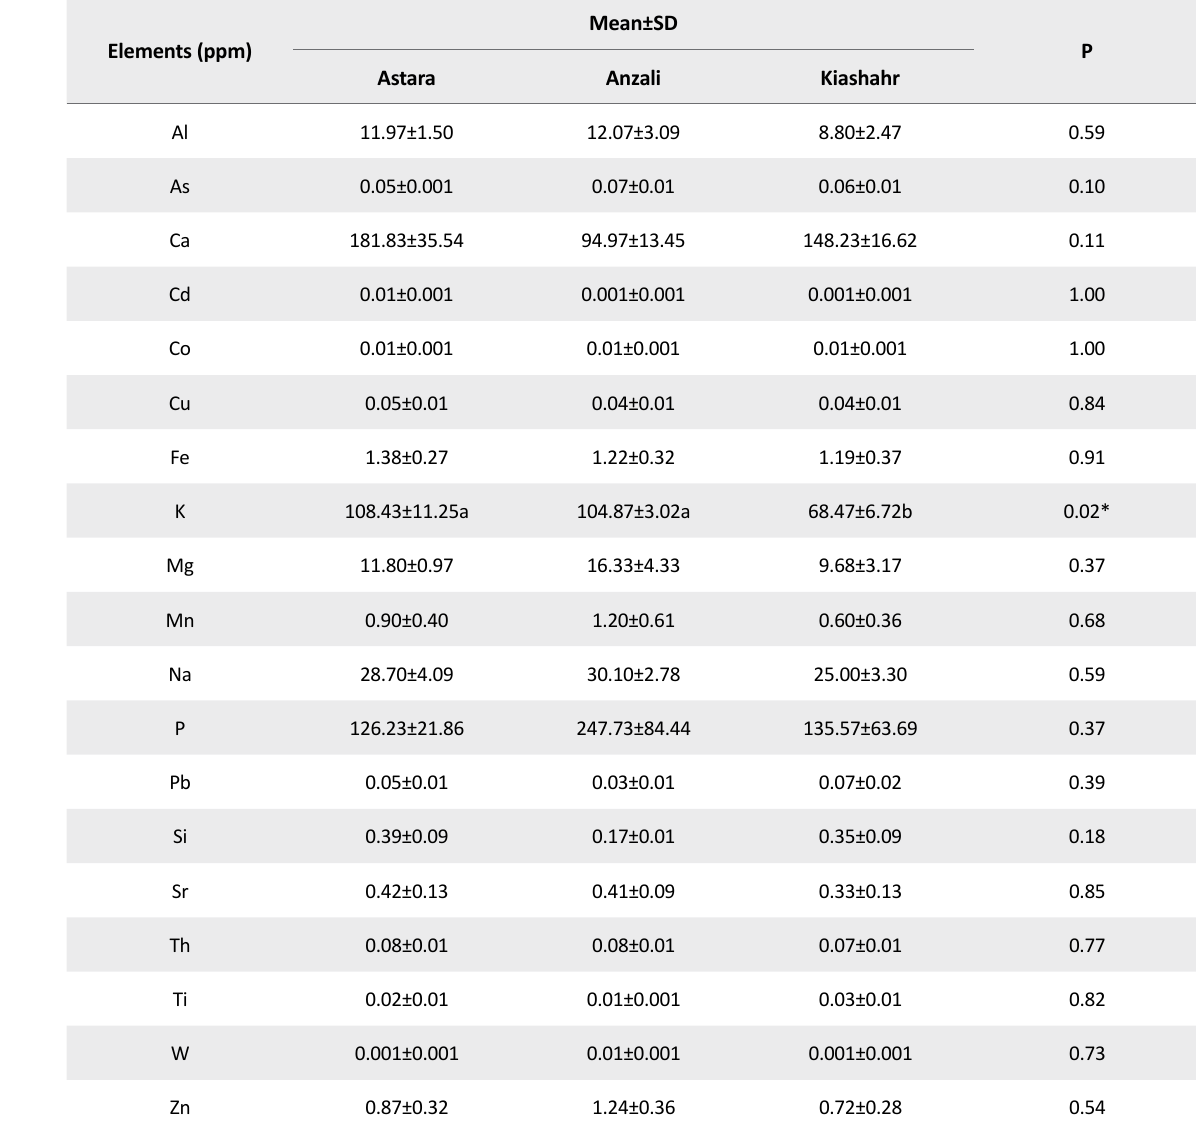
Table 4. Elemental concentrations of the skin in three different stations in the Caspian Sea,